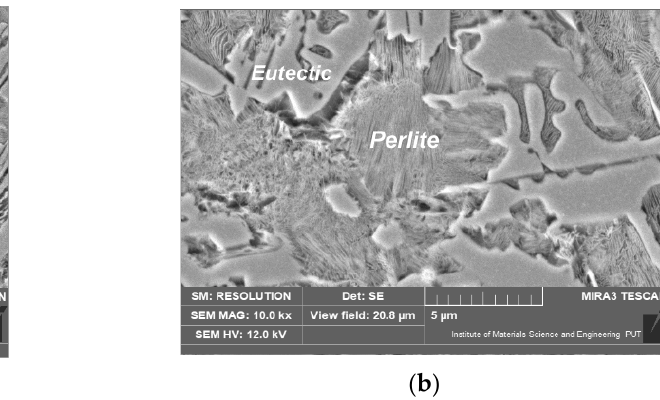
Figure 13. Microstructure of nodular cast iron surface layer, after laser alloying with cobalt (scanning electron microscope, etched with nital 3%). Lens magnification: ( a ) 5000×; ( b ) 10,000×. After laser alloying with fine Si 3 N 4 , a dendritic microstructure was found. In this variant, as in the case of laser alloying with silicon, a microstructure similar to hardened white cast irons was formed (Figure 14).